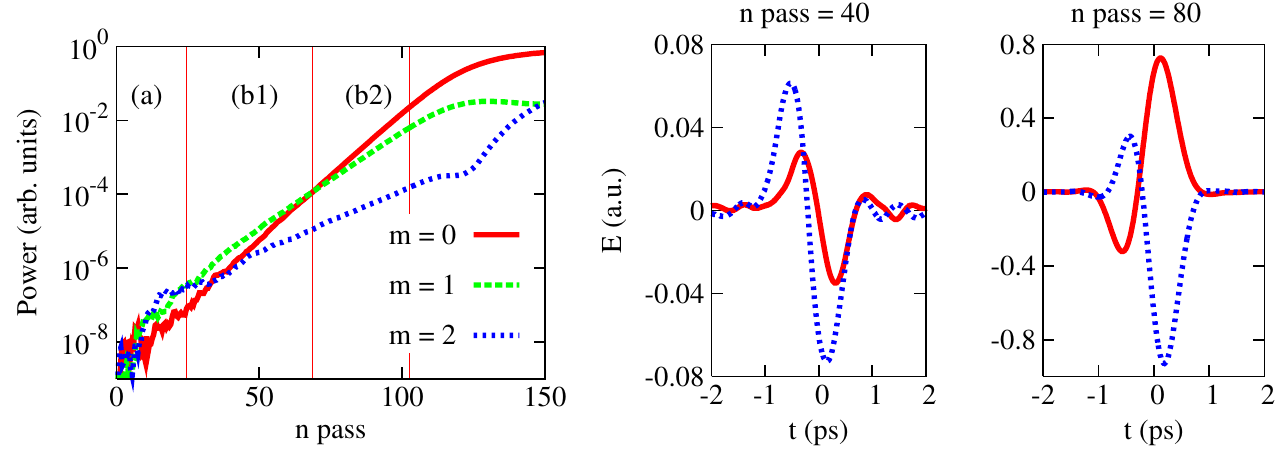
FIG. 3. (Color) Example where the initial random seeding is largest in the m ¼ 1 mode, using the same parameters (but different seeding) as in Fig. 1. The first plot shows initial seeding of the first-order mode in region (a), after which the linear growth phase is dominated by the m ¼ 1 mode through region (b1). Because of its larger growth rate, the component of the m ¼ 0 mode eventually becomes dominant in region (b2). We show examples of the real (red solid line) and imaginary (blue dotted line) parts of the scaled electric field after 40 passes and after 80 passes. While there is still a significant antisymmetric part after 80 passes, it becomes a diminishing component, and at saturation the pulse is nearly